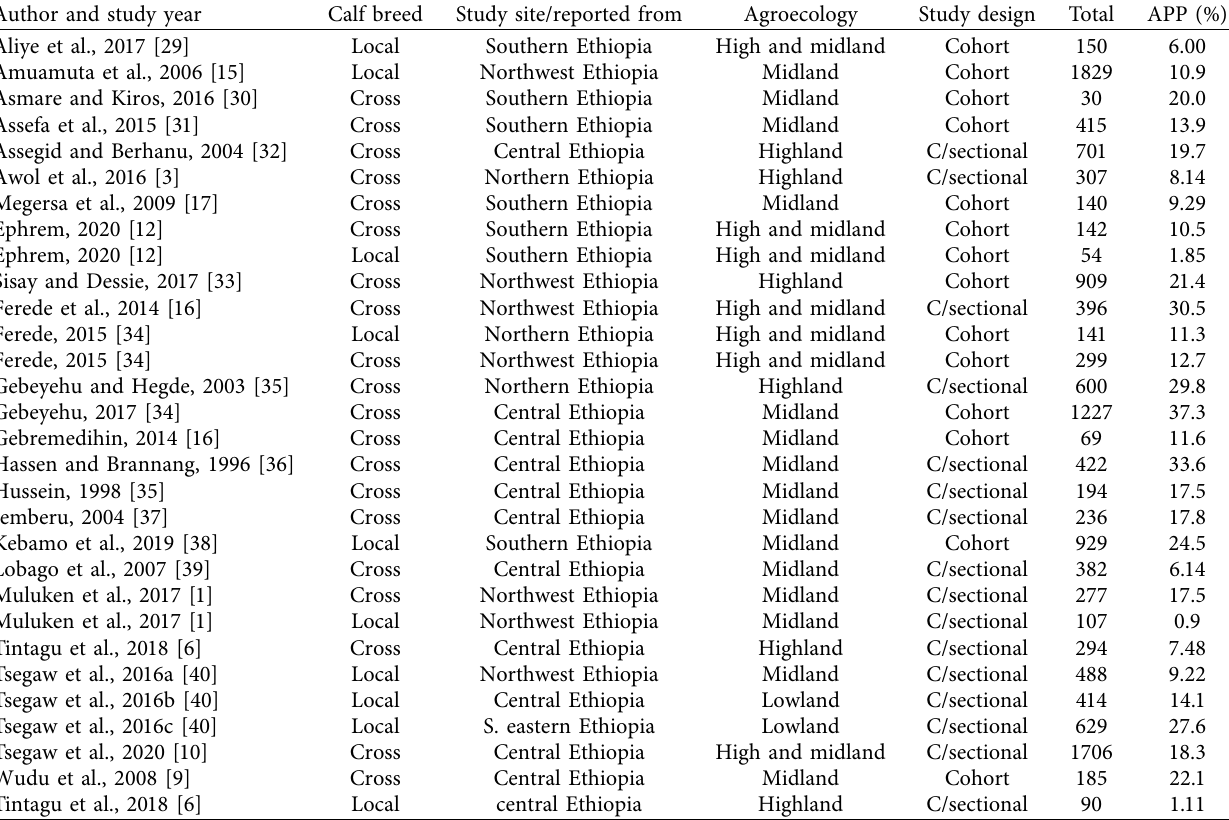
Table 1: Study reports included in a meta-analysis of calf mortality in calf breeds in